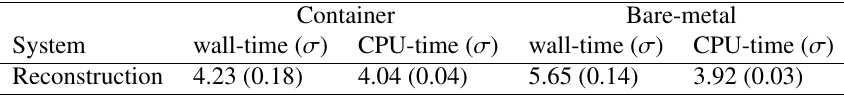
Figure 9. Timing comparison for reconstruc- tion test. Table 3. Timing comparison for real data workflows (times in